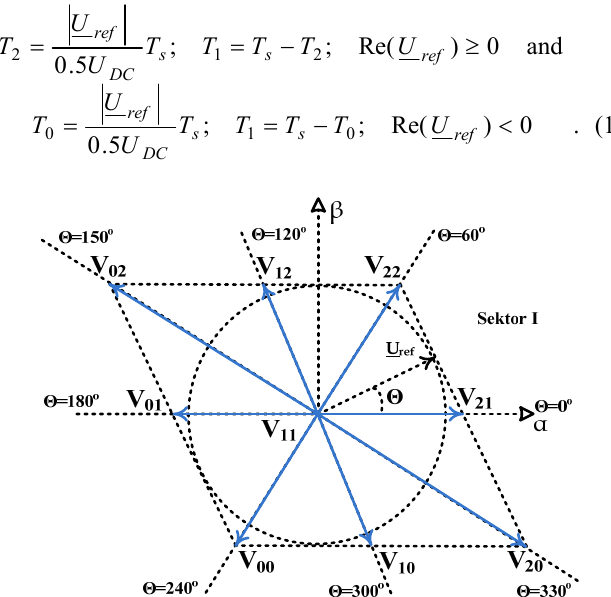
Fig. 3. Possible voltage vectors generated by the simplified three-phase DC/AC